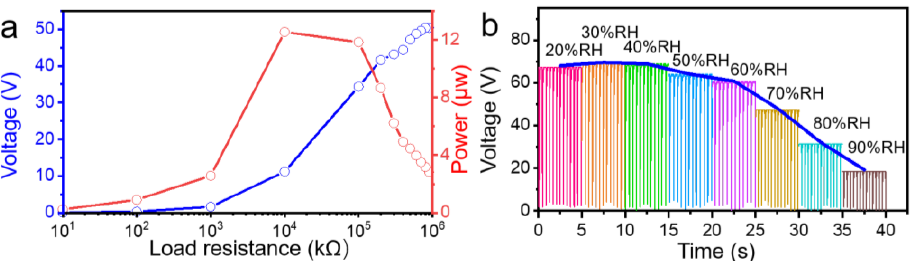
Figure 6. ( a ) Load voltage and peak power curves and ( b ) voltage output under different ambient relative humidity conditions of double-side EPS with PVDFnfs samples.